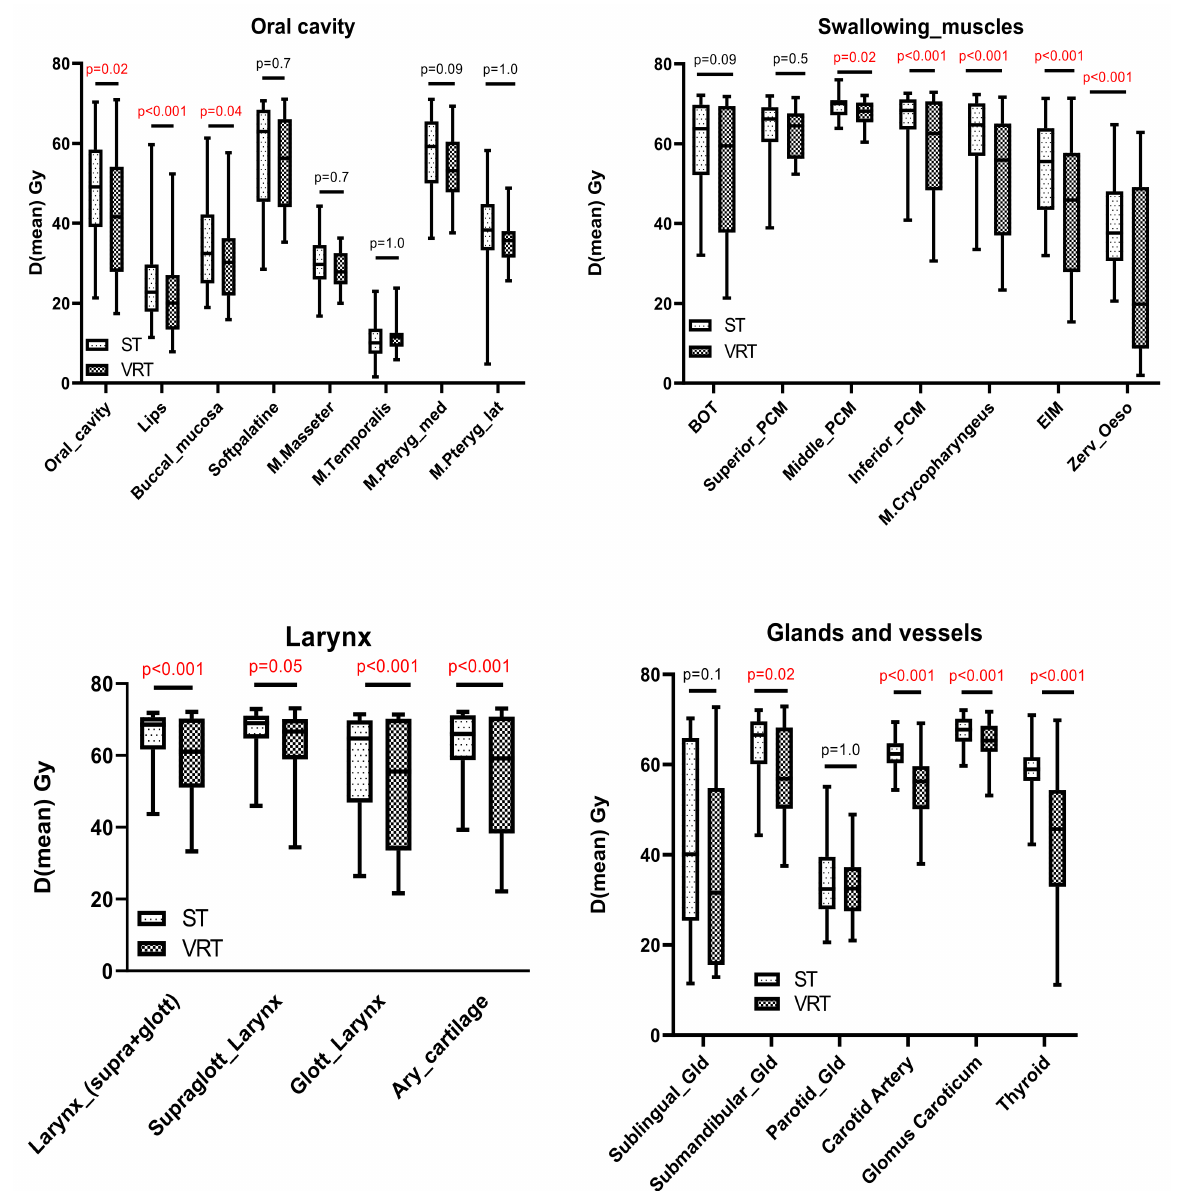
Figure 3. Box-Whisker-Plot comparing the different mean dosages for four different groups of organs at risk comparing standard treatment (ST) and simulated volume reduced treatment (VRT). Graph show median + IQR and statistical analysis was carried out via students t-test for dependent